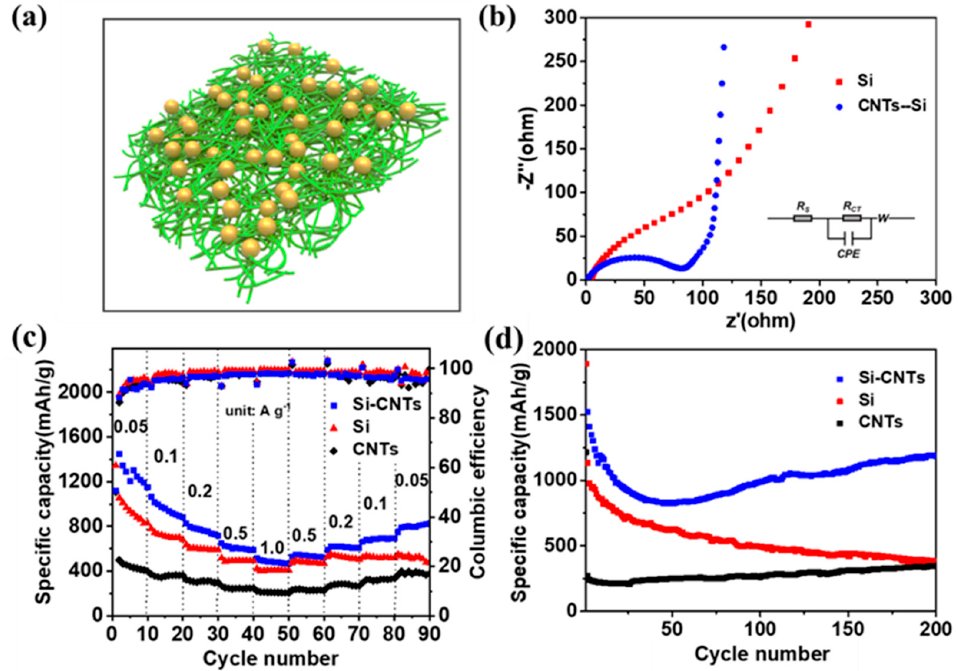
Fig 4 in manuscript Figure 4. ( a ) Hollow Si-CNT material structure model and EIS curve. ( b ) Rate performance. ( c ) Cycle performance at 0.2 A g − 1 . ( d ) Si-CNT